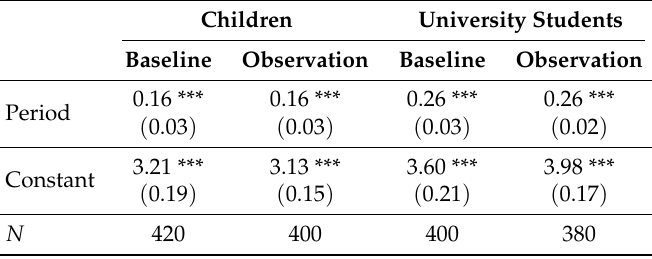
Figure A3. Average choices over time. Table A1. Random effects regression: time trend in urn